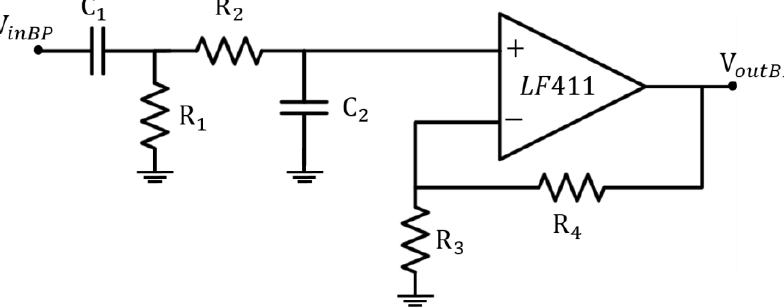
Figure 4. Active band-pass filter schematic circuit.